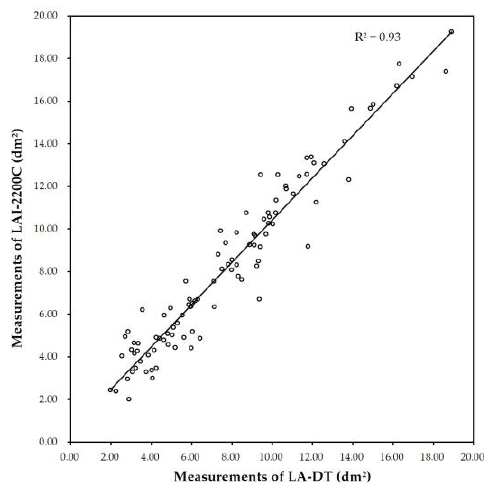
Figure 8. Linear regression analysis of LA-DT and LAI-2200C.